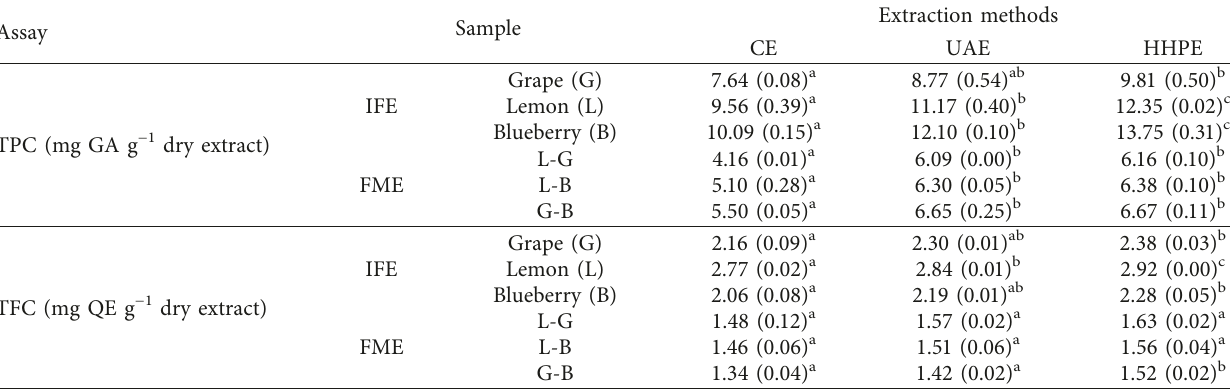
Table 4: Total polyphenolic content (TPC) and total flavonoid content (TFC) for different extraction methods from fruit and fruit mixture. Assay